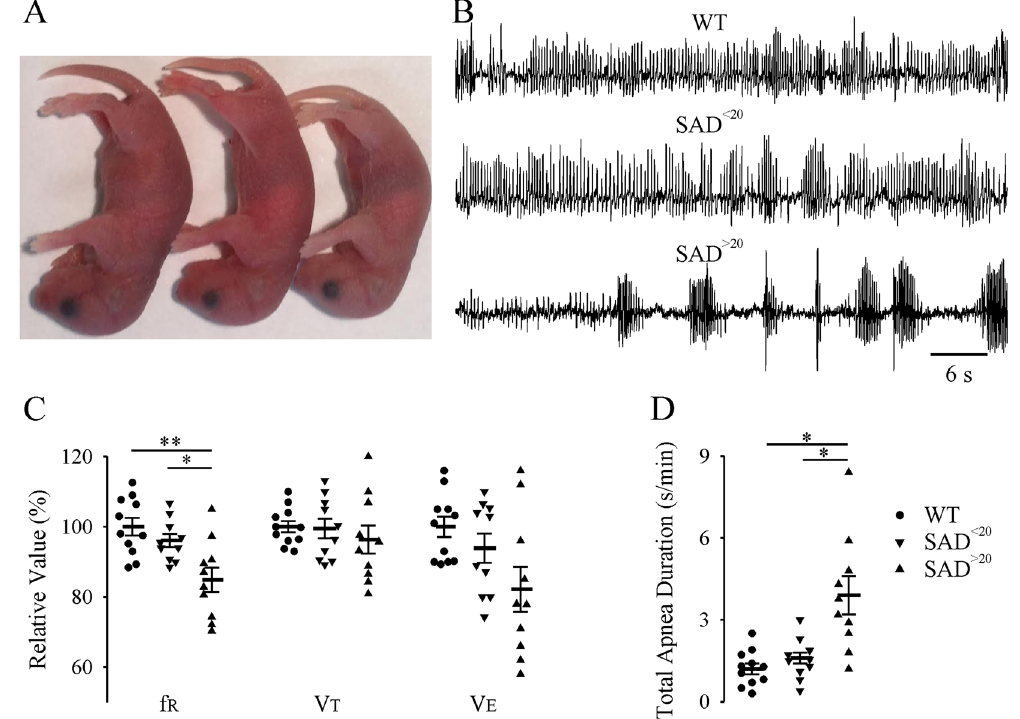
Figure 1. Decreased body size and abnormal respiratory activity in a cohort of SAD mouse pups. ( A ) Representative pictures of decreased body sizes in newborn SAD mice: WT (left), SAD < 20 (middle, body weight of less than 20% decrease), and SAD > 20 (right, body weight of more than 20% decrease). The SAD > 20 appears pallor. (B) Representative plethysmographic recordings demonstrating abnormal respiratory activity in some P3 SAD mice: regular breathing patterns in WT (top) and SAD < 20 (middle), irregular breathing patterns with periods of apnea in SAD > 20 (bottom) mice. Population data (relative to WT) : (C) respiratory variables (frequency: f R ; tidal volume: V T ; minute ventilation: V E ); (D) Total apnea duration. * p < 0.05; ** p < 0.01; one- way ANOVA followed by Holm-Sidak method for ( C ). * p < 0.05; Kruskal-Wallis one-way ANOVA on ranks followed by Dunn’s method for ( D